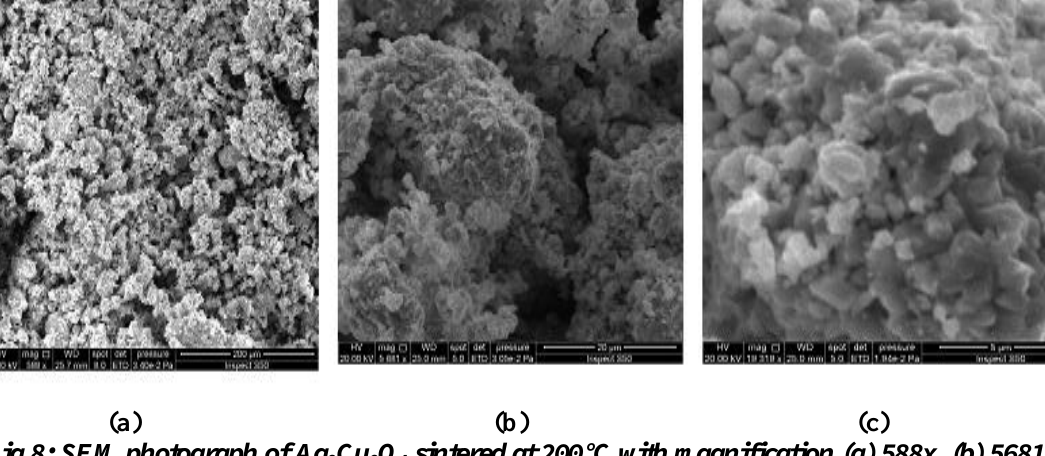
Cu O sintered at 200°C with magnification (a) 588x, (b) 5681x 2 2 4